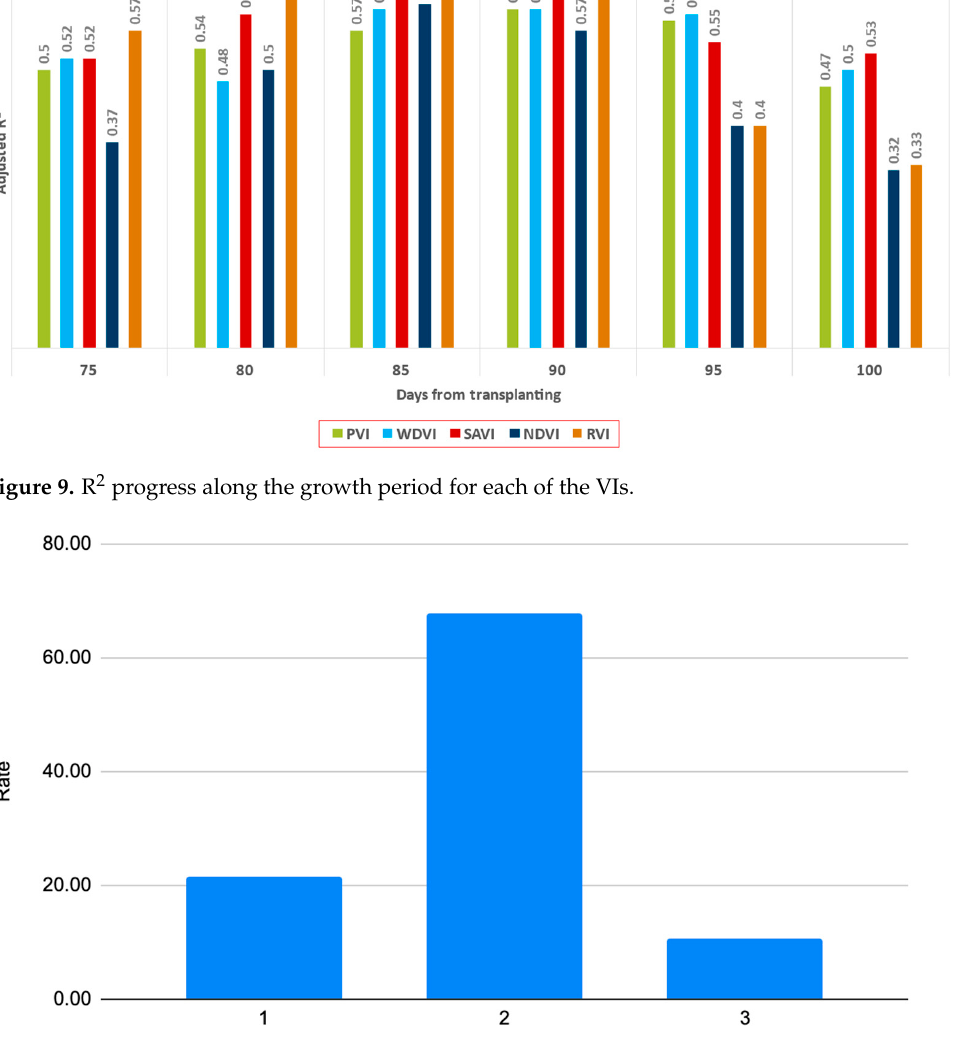
Figure 9. R 2 progress along the growth period for each of the VIs.